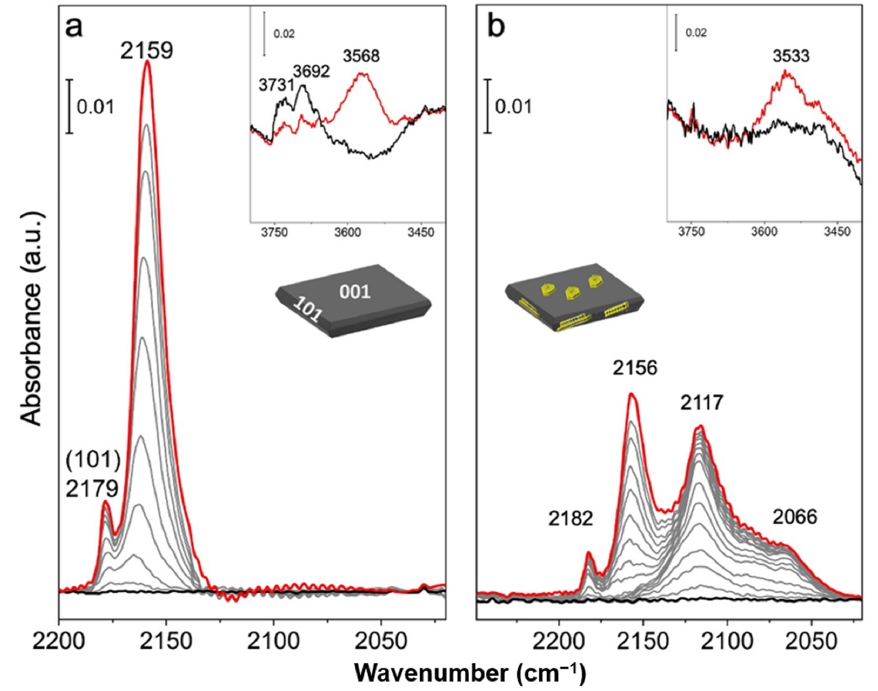
Figure 6. FTIR spectra of CO adsorbed at 77 K (40 Torr, red line) at decreasing coverage up to the residual pressure of 4 × 10 − 4 Torr (black line) on the surface of: ( a ) TiO 2 n-sh and ( b ) MoS 2 /TiO 2 n-sh. The insets show the OH vibrational modes regions before (black line) and after CO dosage (red line).